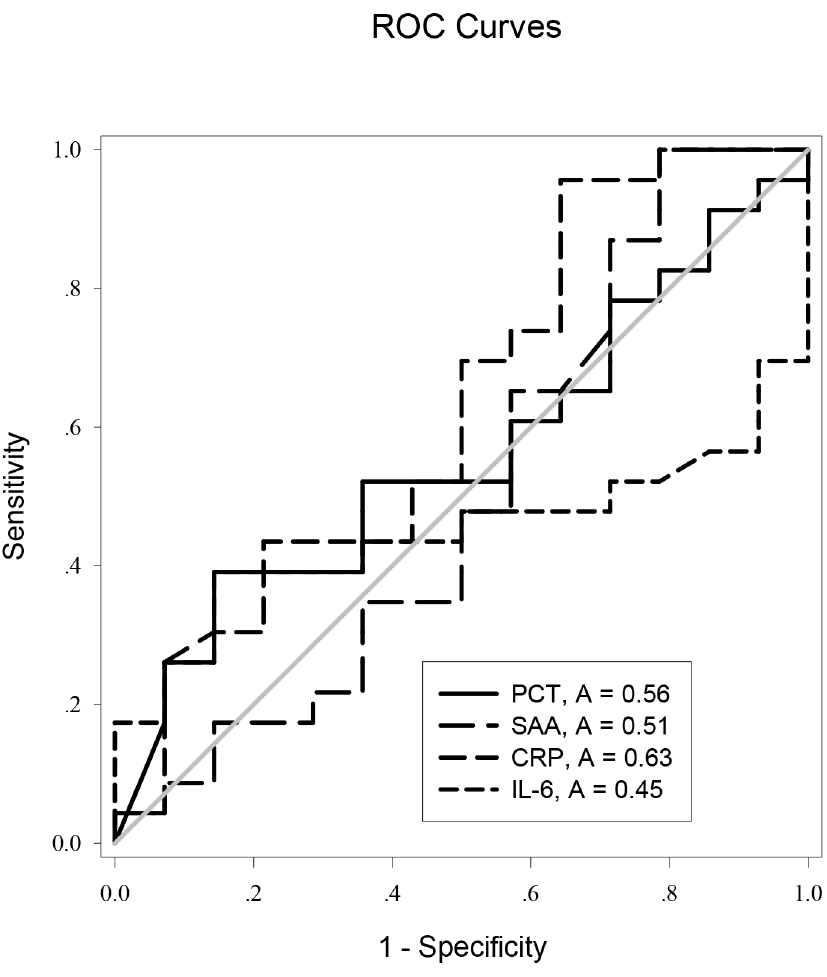
Figure 6. Receiver operating characteristic (ROC) curves for PCT, SAA, IL-6, and CRP for AKI prognosis.